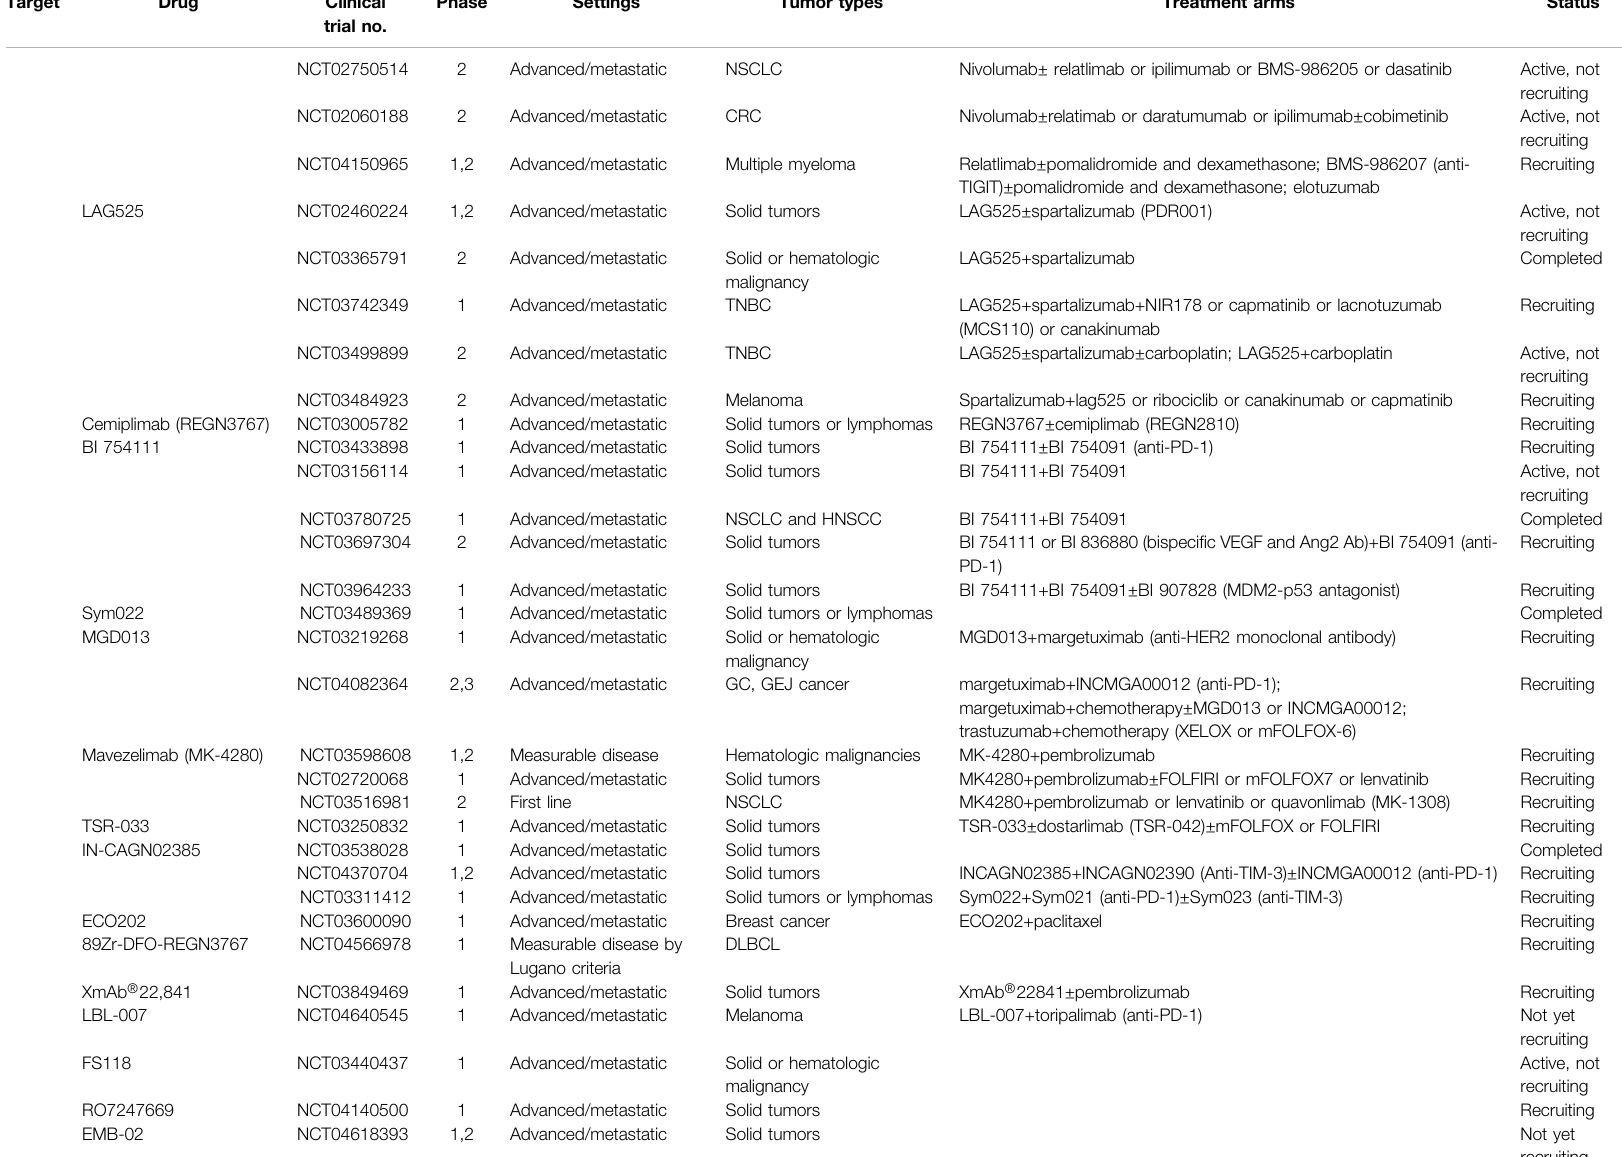
TABLE 3 | ( Continued ) Clinical trials on novel immune checkpoint